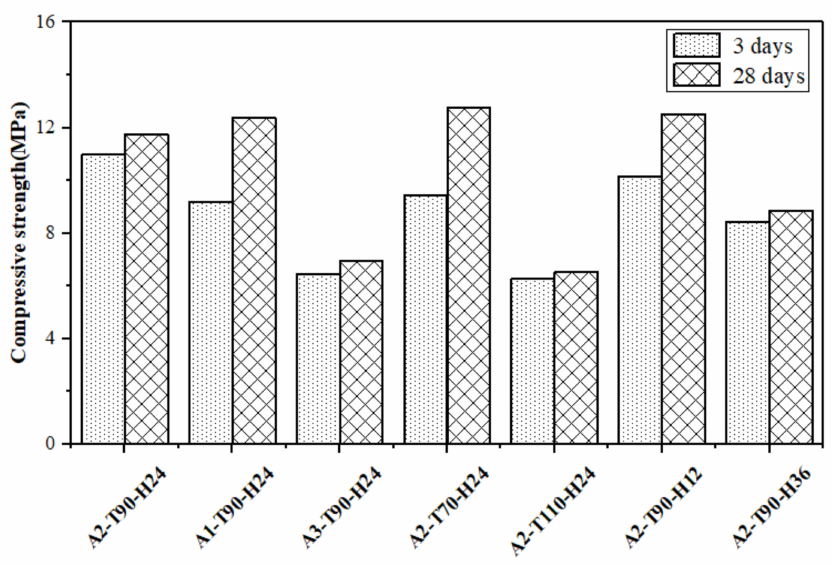
Figure 7. Compressive strength of self-supporting zeolite blocks.